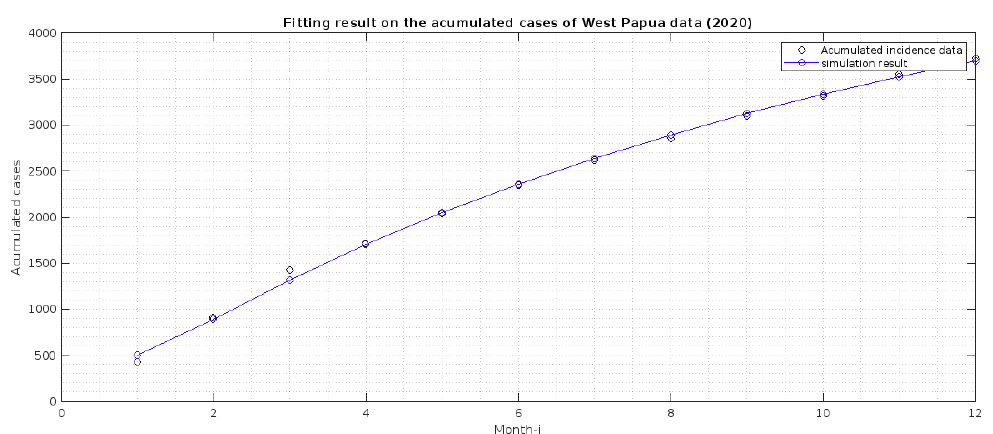
Figure 3. Estimation result of fitting the accumulated cases in West Papua with c ( t ) in Equation (3). The best-fit initial conditions for S 1 , E 1 , I , T , R 1 , R 2 , V , W are 974,300, 400, 400, 51, 21, 125, 1,789,099, 202,